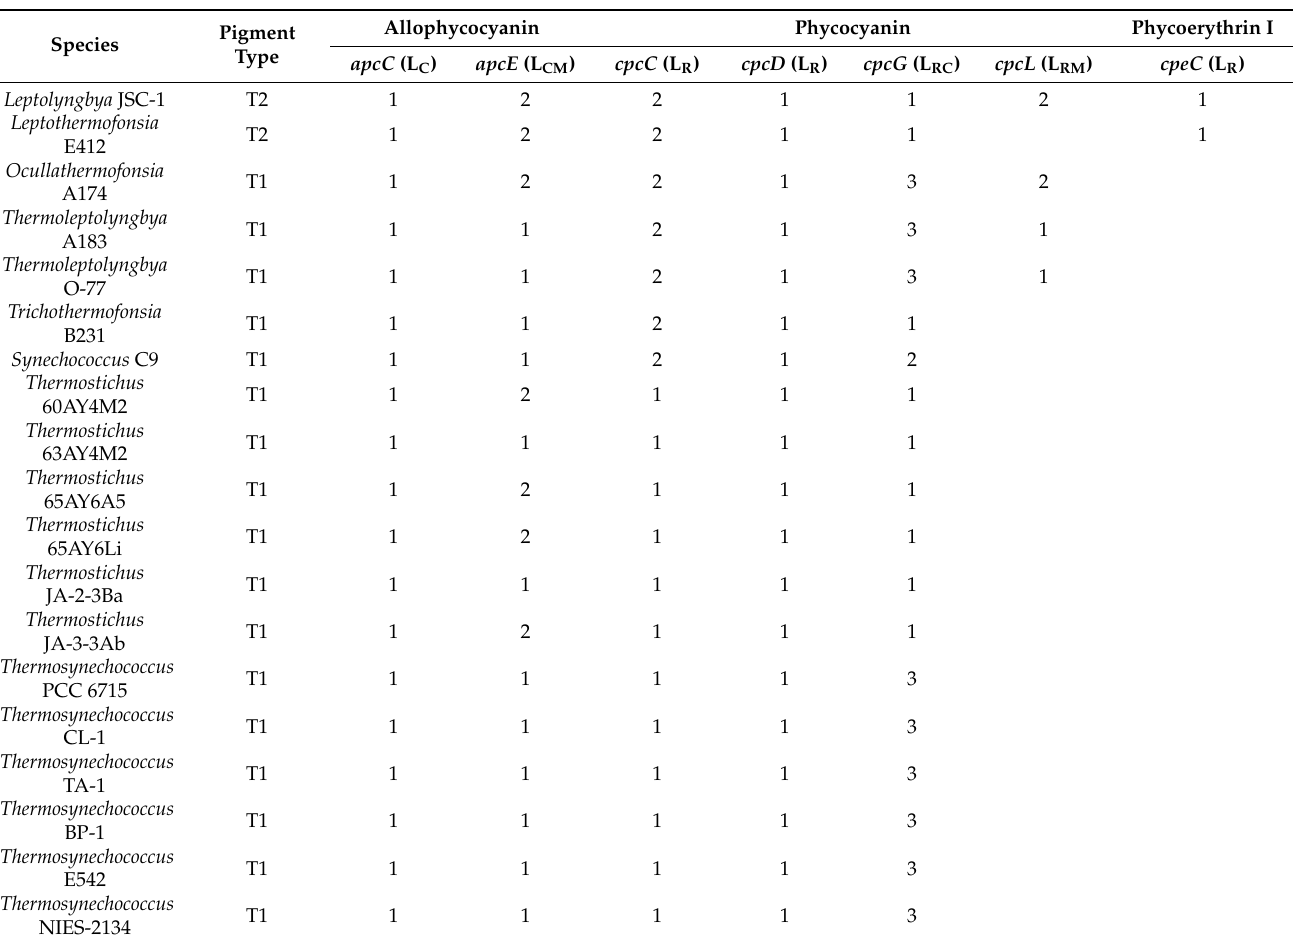
Table 3. Availability of genes encoding linker polypeptides in the genomes of thermophilic cyanobac- teria